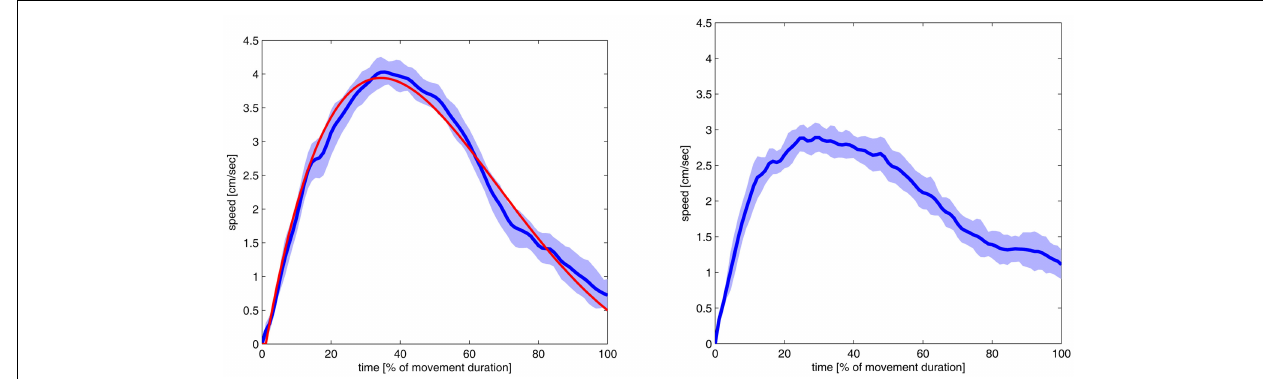
10 time slices of the movement.The result on the right side was produced with a standard topological encoding in the V map of the MovementVelocity Control module. On the left a non-linear encoding was used.This encoding schema let to better reaching movements.The red line documents the outcome of theVITE-model fitted to the robot arm behavior (see main text for detailed discussion). Both velocity profiles are the average of 25 trials.